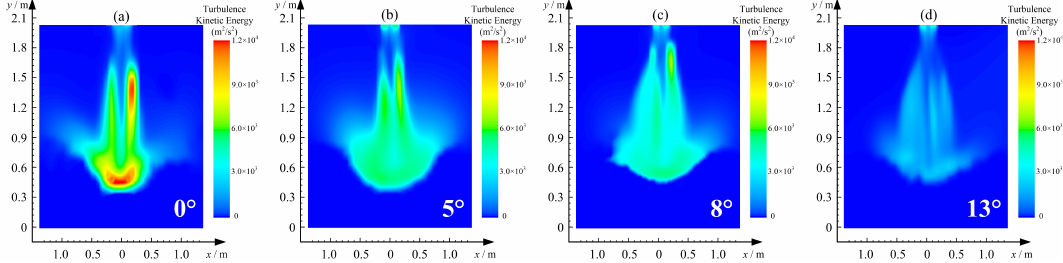
Figure 8. Turbulence kinetic energy profiles in top-blowing steelmaking with different multi-nozzle oxygen lances. ( a ) NTA = 0 ◦ ( b ) NTA = 5 ◦ ( c ) NTA = 8 ◦ ( d ) NTA = 13 ◦